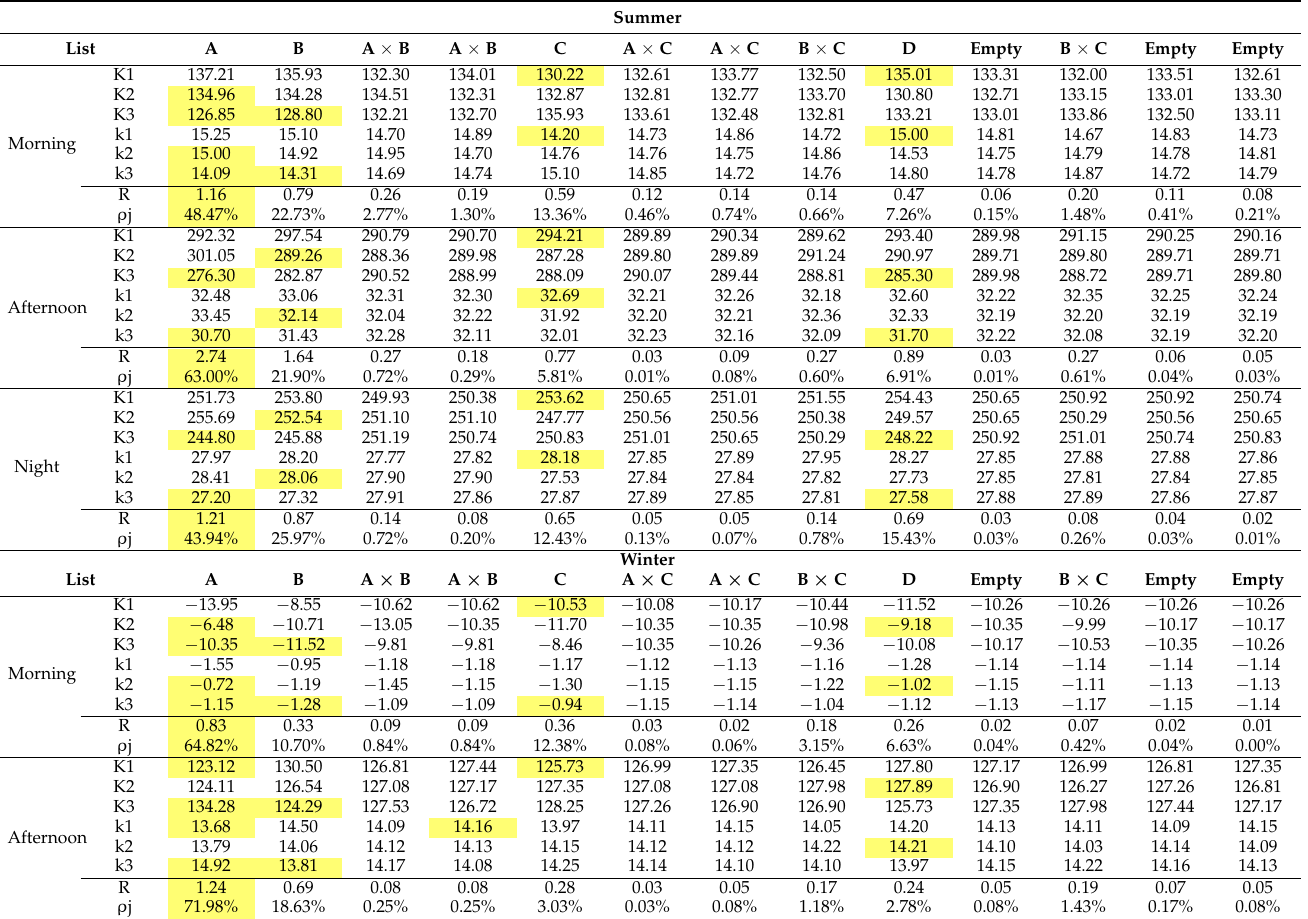
Table 8. Results of orthogonal test in summer and